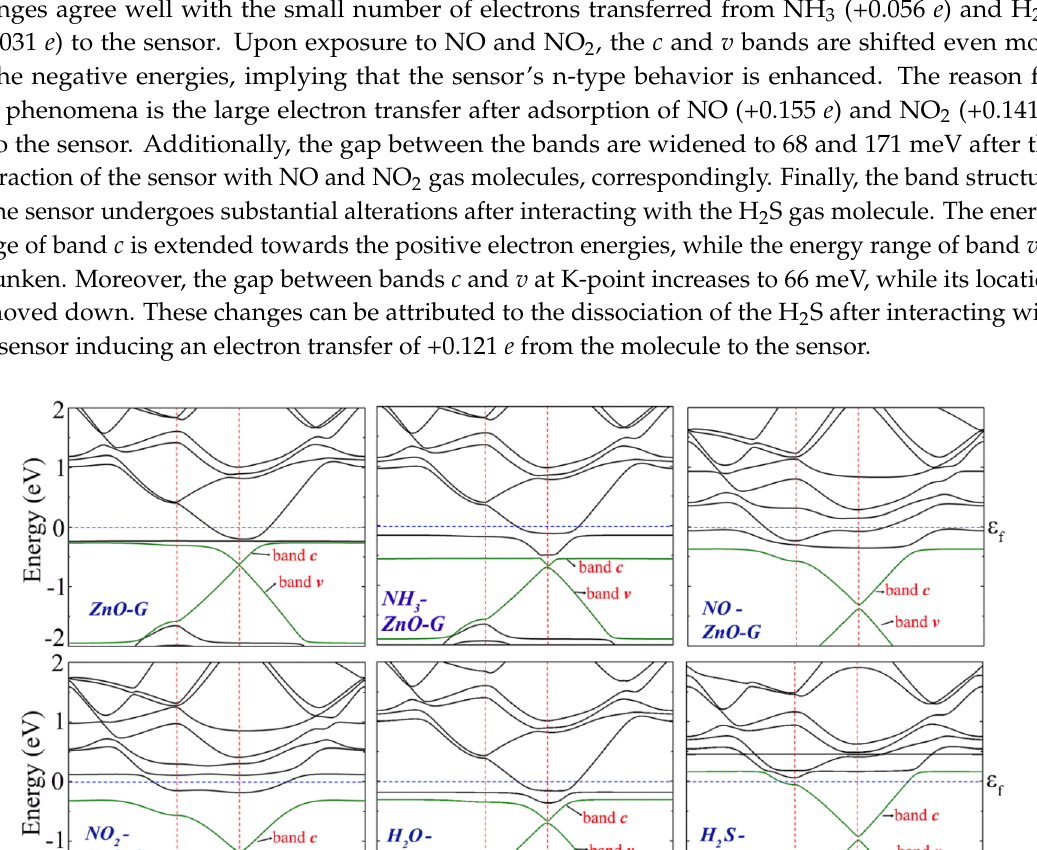
Figure 5. The electronic band structures of the ZnO–graphene sensor before and after adsorption of NH 3 , NO, NO 2 , H 2 O, and H 2 S. Valance and conduction bands are highlighted in green. The Fermi levels, indicated in blue dashed lines, have been set to 0 eV.